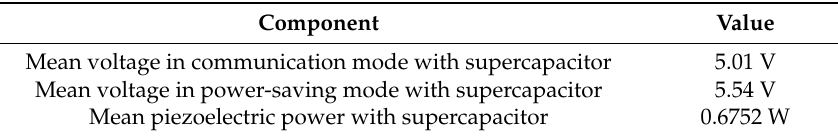
Table 6. Summary of the medium-power piezoelectric harvester